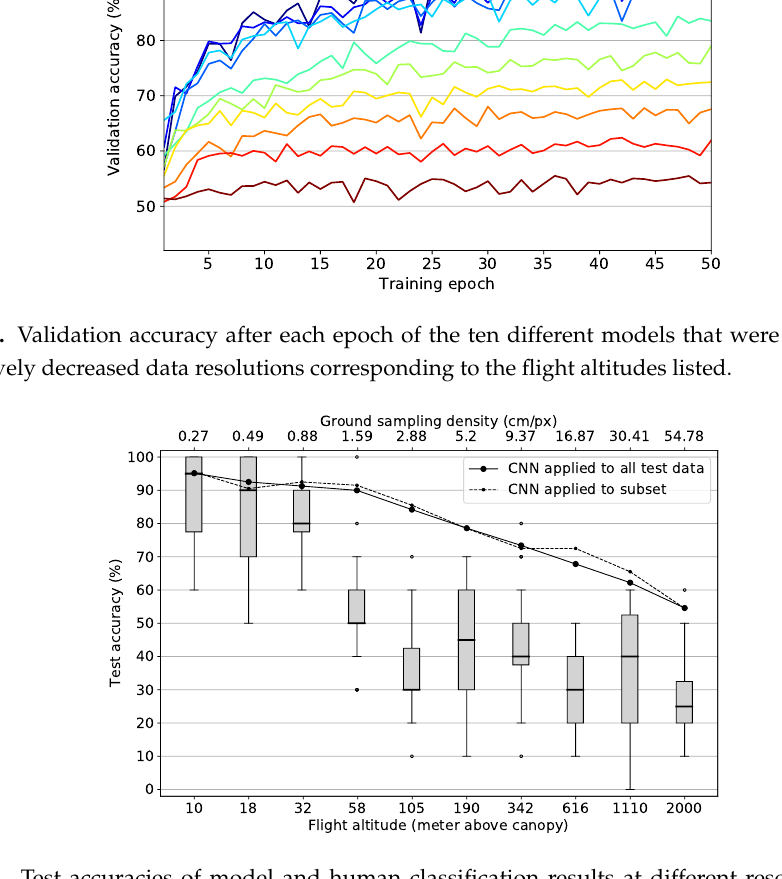
Figure 8. Test accuracies of model and human classification results at different resolution levels corresponding to the flight altitudes and ground sampling densities depicted on the horizontal axes (logarithmically scaled). Lines denote model results. Boxplots show human